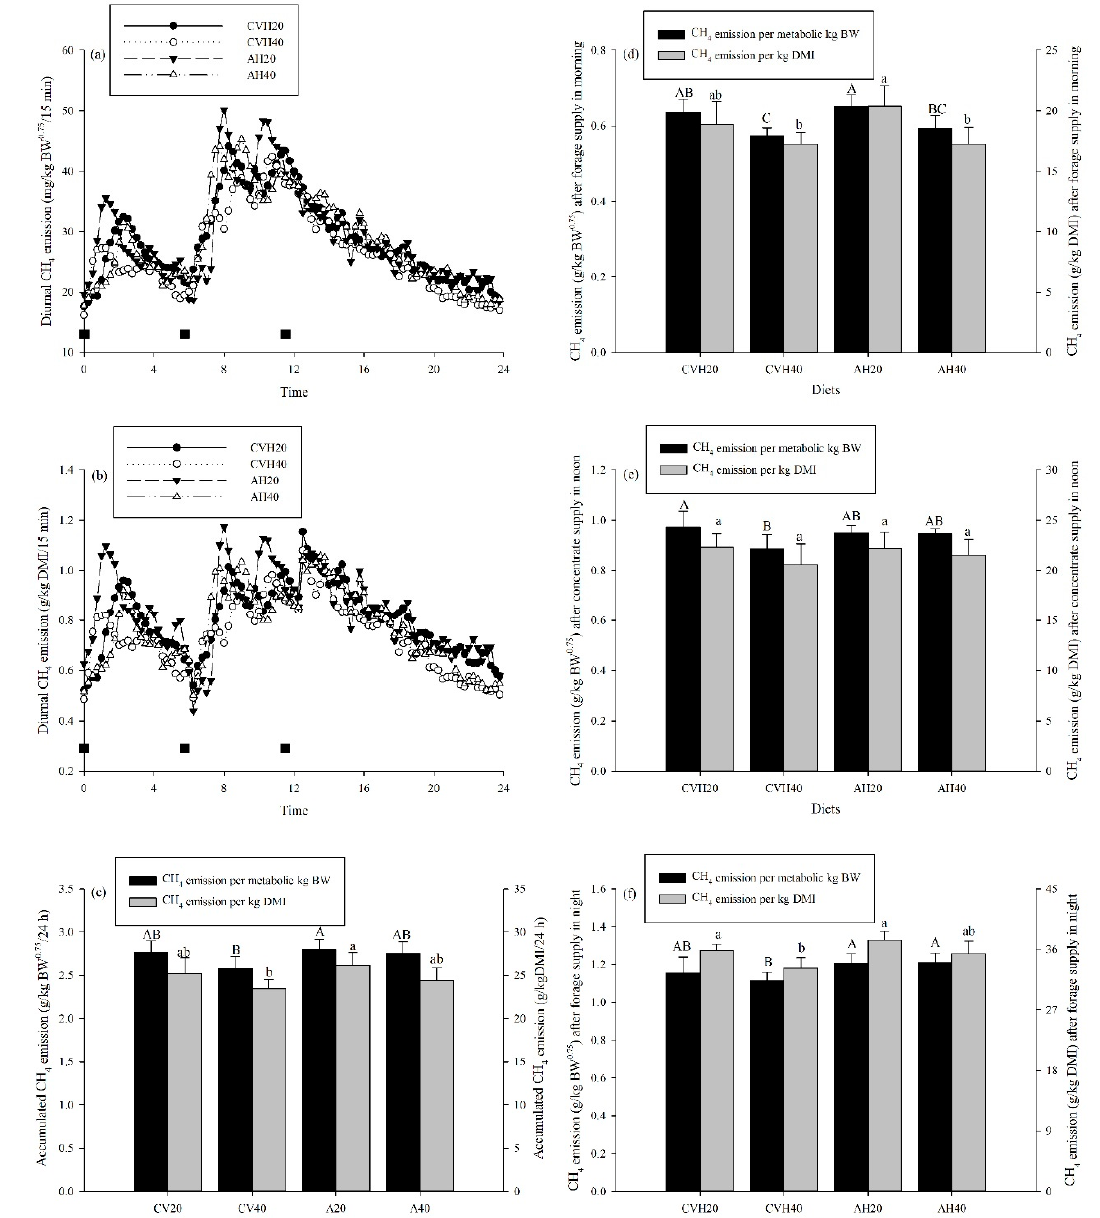
Figure 2. Diurnal CH 4 emissions ( a ) and ( b ), accumulated CH 4 emissions ( c ) after forage supply in the morning ( d ), after the concentrate supply in noon ( e ) and after forage supply in the night ( f ) for cattle among the four diet groups. Values are presented as the mean ± standard deviation (SD). Uppercase letters represent the differences among the four diet groups per kilogram of metabolic body weight, and lowercase letters represent the difference among the four diet groups per kilogram dry matter intake (DMI).